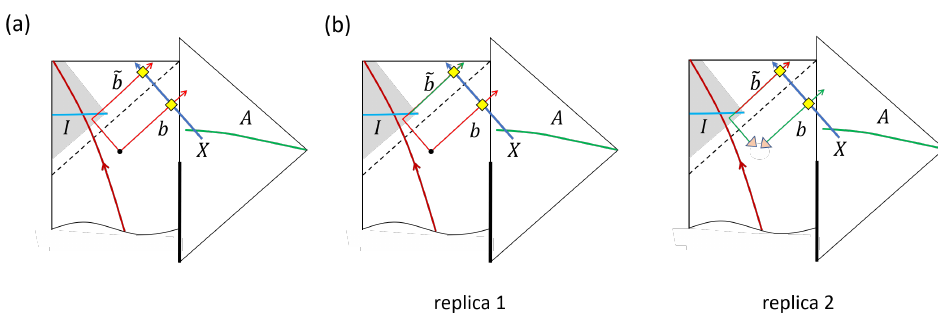
Figure 6 . (a) Illustration of a pair of qubits b, ˜ b , when ˜ b ∈ I and b / ∈ A . An infalling observer X carries a binary measurement that checks if b ˜ b is in the particular entangled state. (b) Illustration of the replica geometry that applies operator P ↑↓ which distinguishes the two states with opposite A spin of ˜ b . The green and red lines represent the trajectory of b and ˜ b in the two replicas respectively. (In general there are n replicas. We draw n = 2 here for simplicity.) Since only one of them crosses the branchcut line, X will not see the partner ˜ b but see the copy of ˜ b in a different replica, leading to failure of entanglement